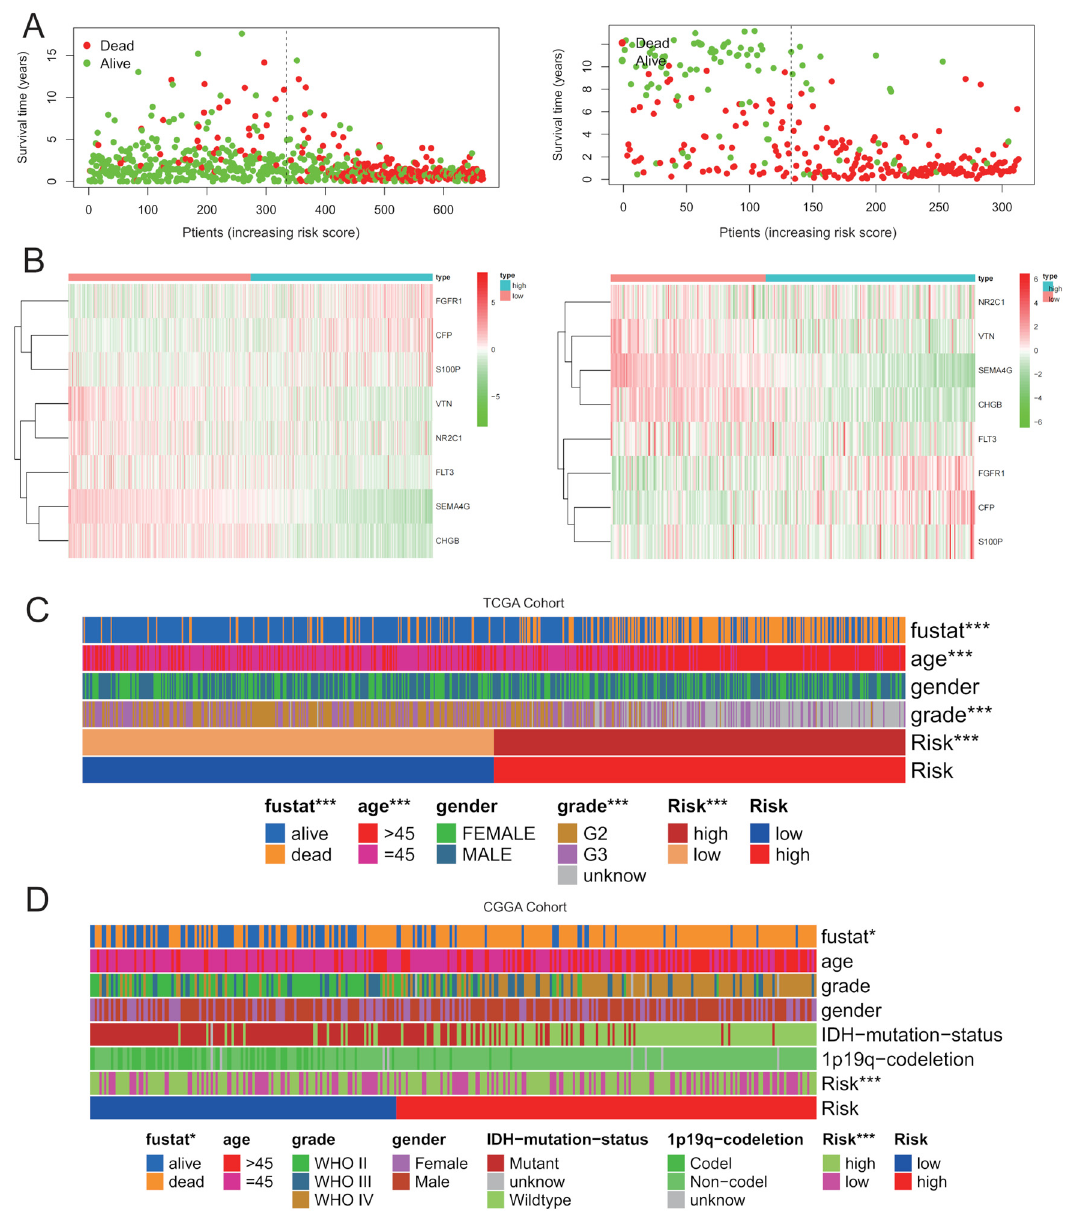
Figure 5. Patient status distribution and clinicopathological features in different IGRPS subgroups. ( A ) Patient status distribution in different IGRPS subgroups. The dots present patient survival status. The X-axis is the number of patients, ranked by increased risk score and the Y-axis is survival rate. ( B ) Heatmap of the expression of eight signature IRGs in patients with different IGRPS risk in two cohorts. ( C , D ) Clinicopathological feature heatmaps of IGRPS in the two cohorts. * p < 0.05, *** p <